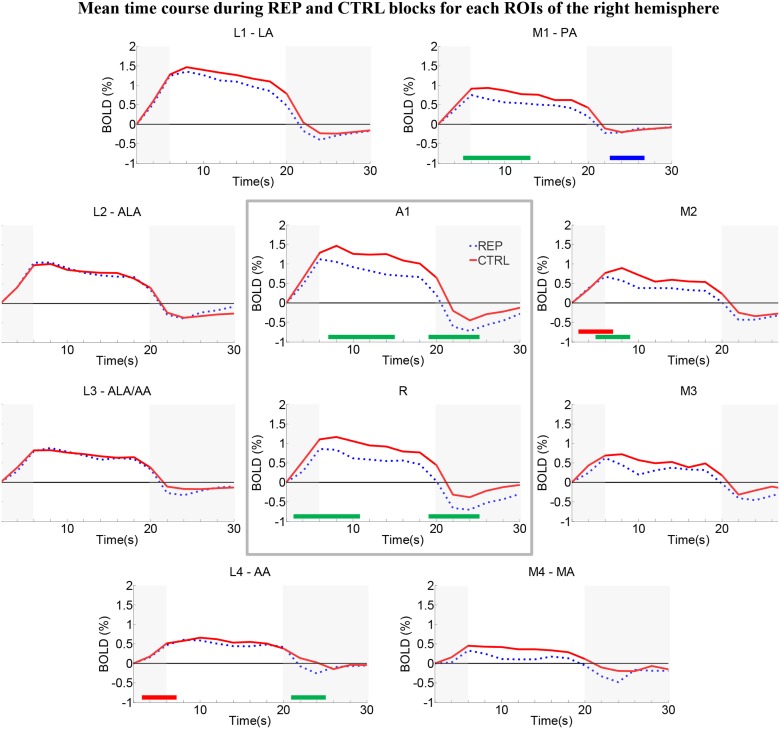
Group average time-courses of the two conditions in the right hemisphere within the auditory cortex ROIs.BOLD signal changes (in %) were plotted across time points of the block. REP blocks tended to yield lower activation than CTRL blocks. Same conventions as in Fig 3.